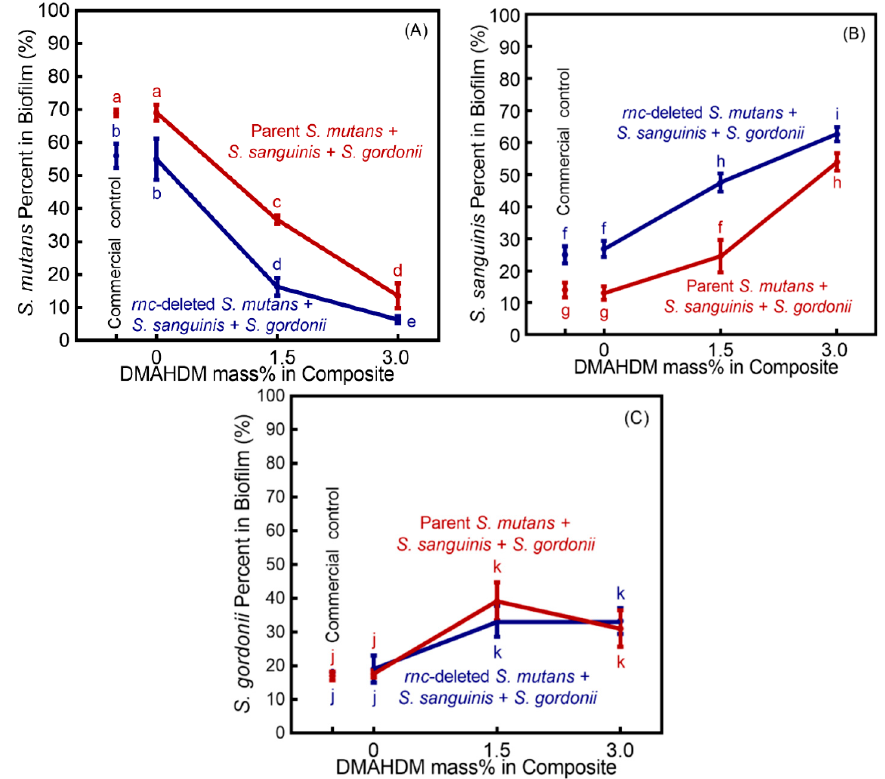
Figure 5. Bacterial species shift in Sm + Ss + Sg biofilm grown for 2 days on composites (mean ± SD; n = 3). ( A ) cariogenic S. mutans proportion, ( B ) non-cariogenic S. sanguinis proportion, and ( C )